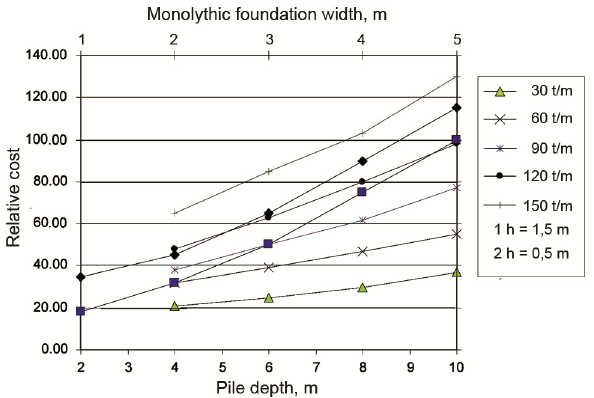
Fig. 9. Relative cost of monolithic (Fig. 1) and pile (300×300)